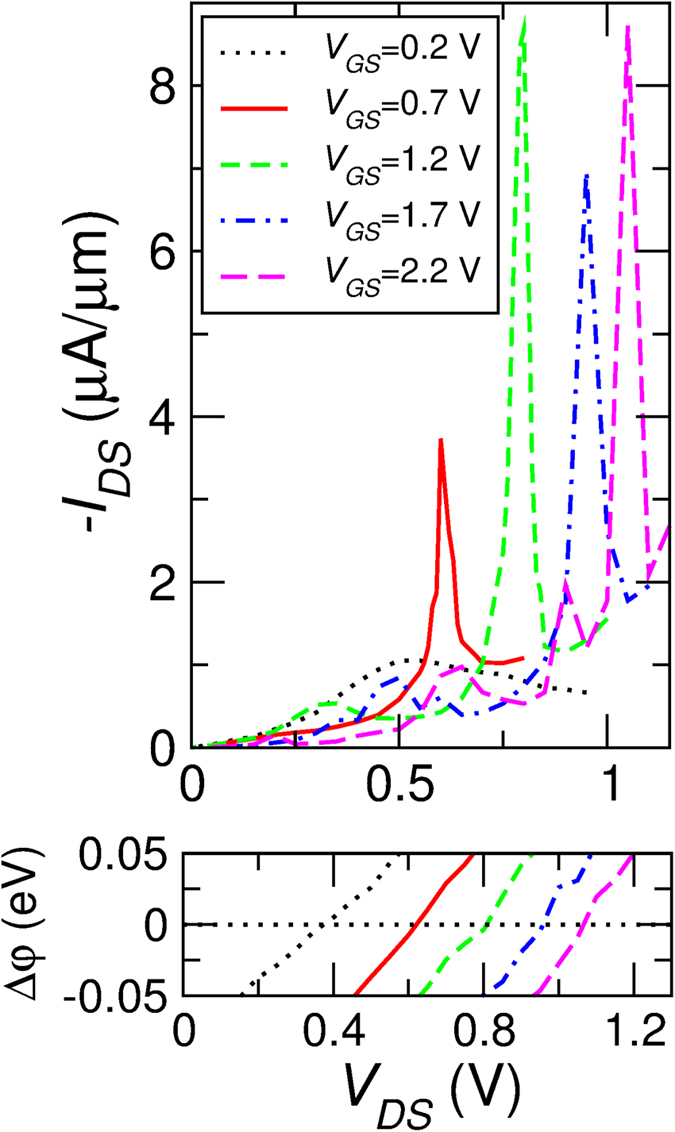
Same as Fig. 8, for the case of a graphene/(5-layer h-BC2N)/graphene heterostructure.